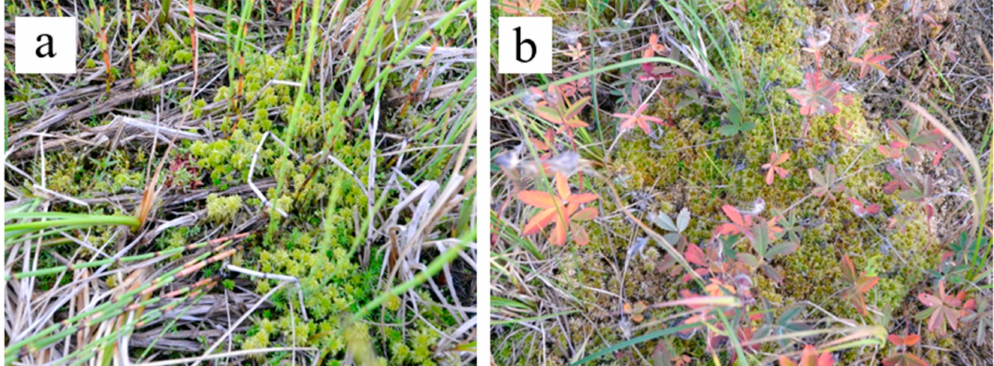
Figure 6. Patches of sphagnum mosses in horsetail-sedge ( a ) and sedge-comarum communities ( b